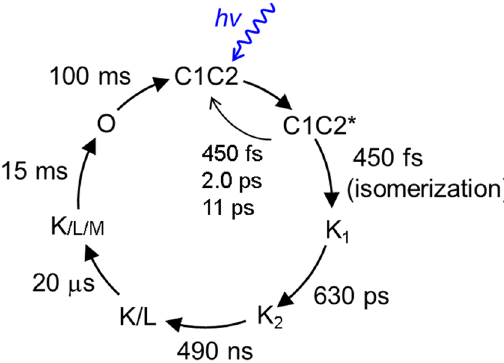
Figure 8. Photocycle models of C1C2 at pH